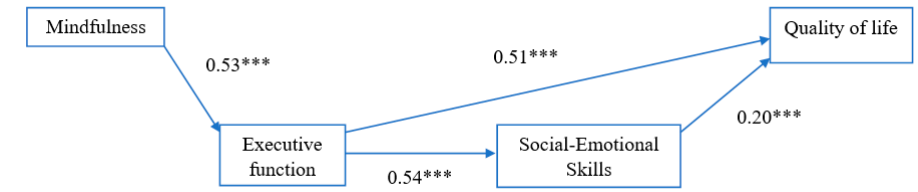
Figure 2. Standardized Direct Effects of Main Variables in SEM; Note: X 2 = 4.1, p = 0.13. *** p < 0.001.